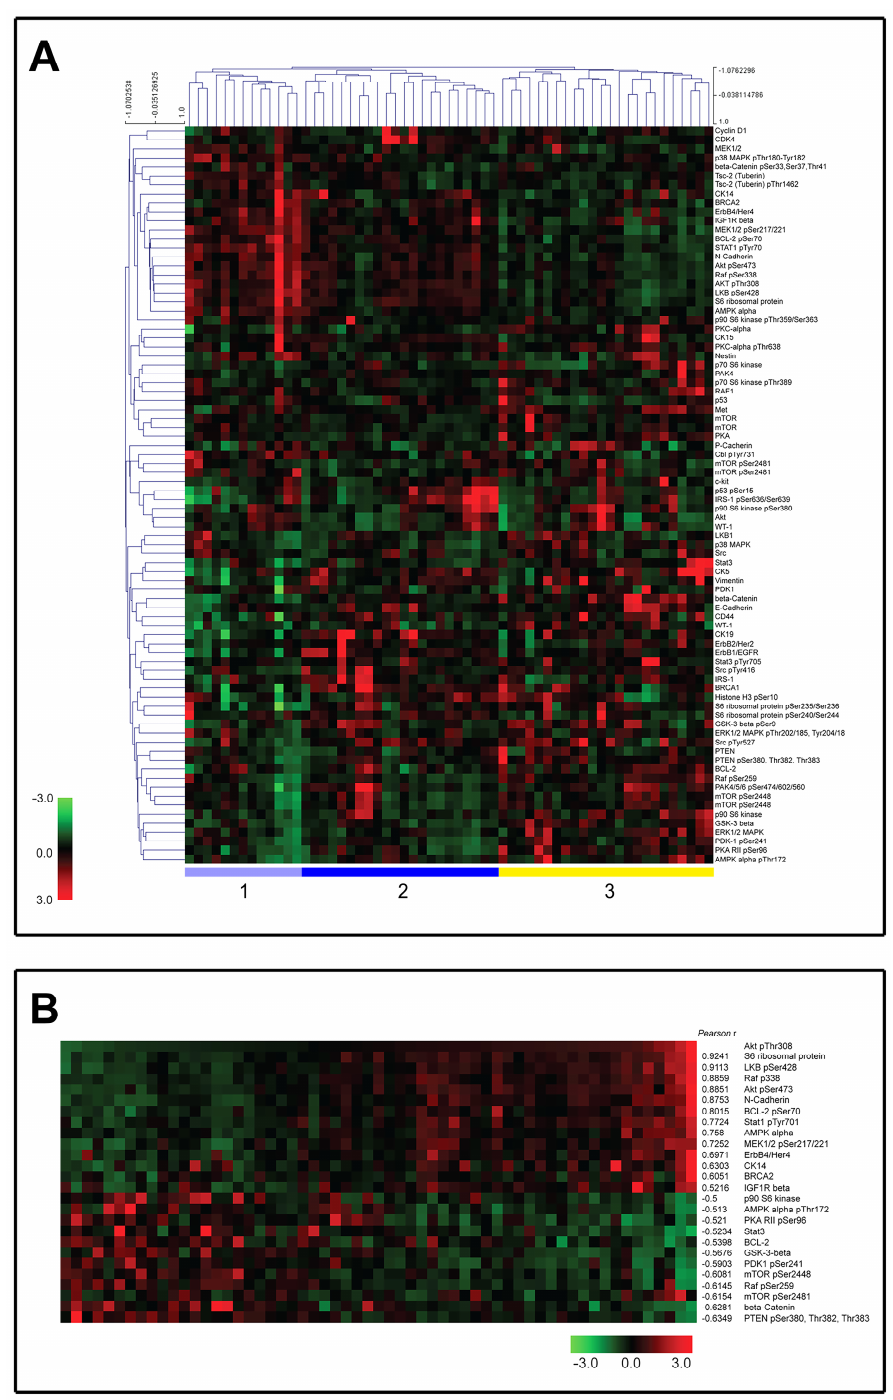
Figure 2. RPPA analysis of 44 TNBC samples. ( A ) Signal intensities were normalized and log2 converted signals were used for an unsupervised hierarchical cluster analysis. A black color indicates the median expression level calculated for a particular protein or phosphorylation across all samples; higher level expression than median is shown as a red color, and a green color refers to a lower than average abundance. Sample names and protein names are listed above and on the right-hand side, respectively. Clusters 1 through 3 are defined at the bottom of heatmap. ( B ) Heatmap of proteins with a Pearson correlation rank above 0.5, sorted by the phosphorylation status of Akt Thr −